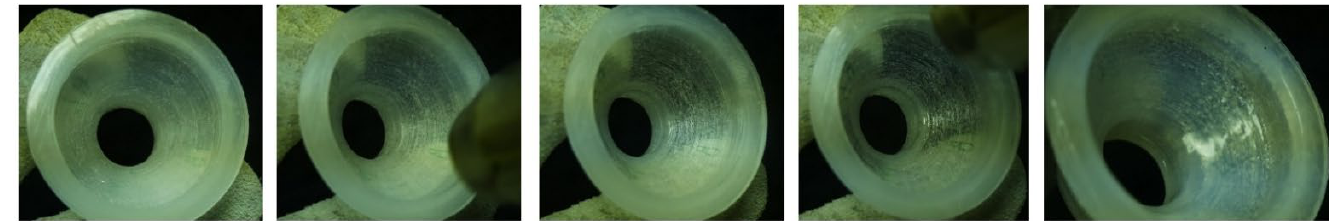
Figure 3. Snapshots from video demonstrating visible change during sealing heat treatment. First and last pictures are before and after sealing, respectively (see Full_Sealing.mp4 video in [38]).